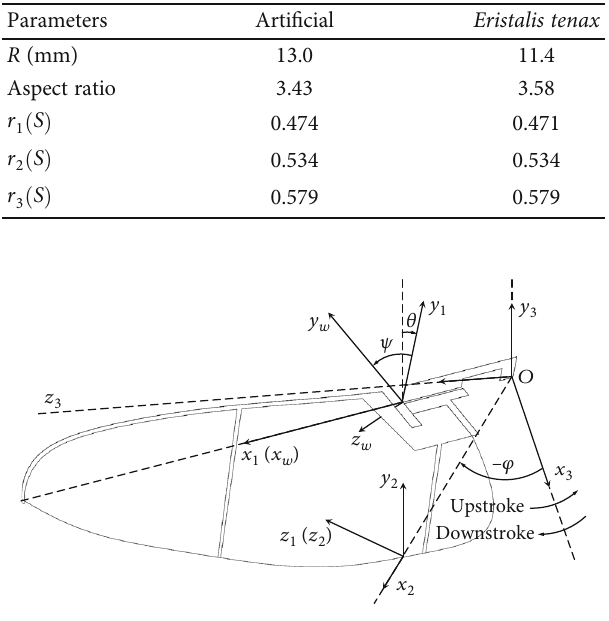
Figure 4: De fi nitions of the coordinate systems and the kinematics of the left arti fi cial wing. Table 3: Mass distribution of the arti fi cial wing.